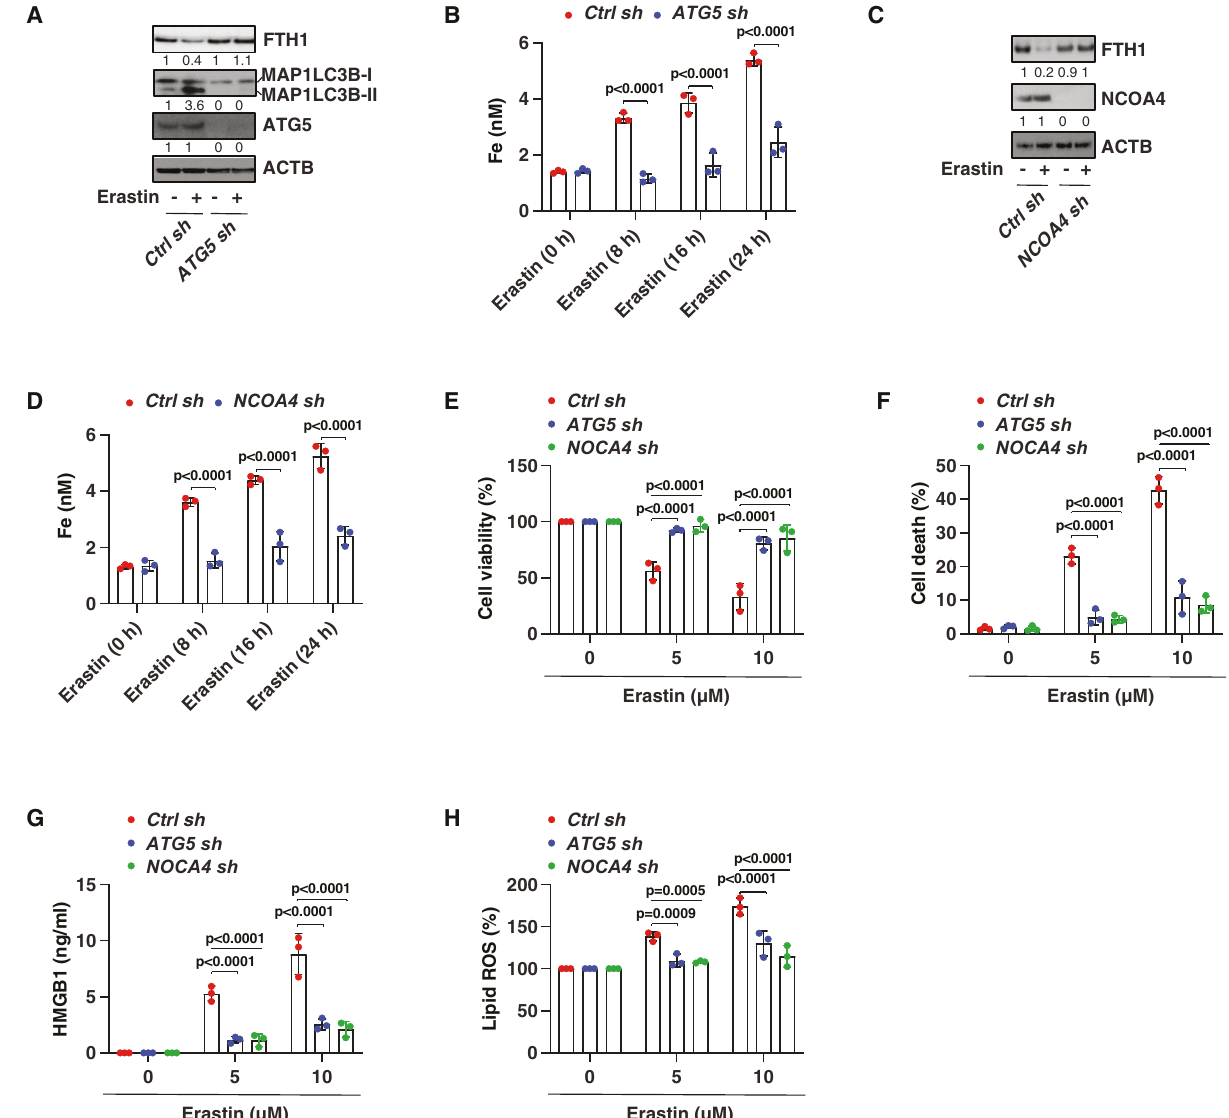
Fig. 3 Ferritinophagy mediates ferroptotic tumor suppression. A Western blot analysis of protein expression in control and ATG5 - knockdown Y79-CR cells following treatment with erastin (10 µM) for 24 h. B Analysis of intracellular free iron in control and ATG5 -knockdown Y79-CR cells following treatment with erastin (10 µM) for 8 – 24 h (two-way ANOVA with Tukey ’ s multiple comparisons test; data are presented as mean ± SD; n = 3 biologically independent samples). C Western blot analysis of protein expression in control and NCOA4 -knockdown Y79- CR cells following treatment with erastin (10 µM) for 24 h. D Analysis of intracellular free iron in control and NCOA4 -knockdown Y79-CR cells following treatment with erastin (10 µM) for 8 – 24 h (two-way ANOVA with Tukey ’ s multiple comparisons test; data are presented as mean ± SD; n = 3 biologically independent samples). E – H Indicated Y79-CR cells were treated with erastin (5 – 10 µM) for 24 h, and then cell viability ( E ), cell death ( F ), HMGB1 release ( G ), and lipid ROS ( H ) were assayed (two-way ANOVA with Tukey ’ s multiple comparisons test; data are presented as mean ± SD; n = 3 biologically independent